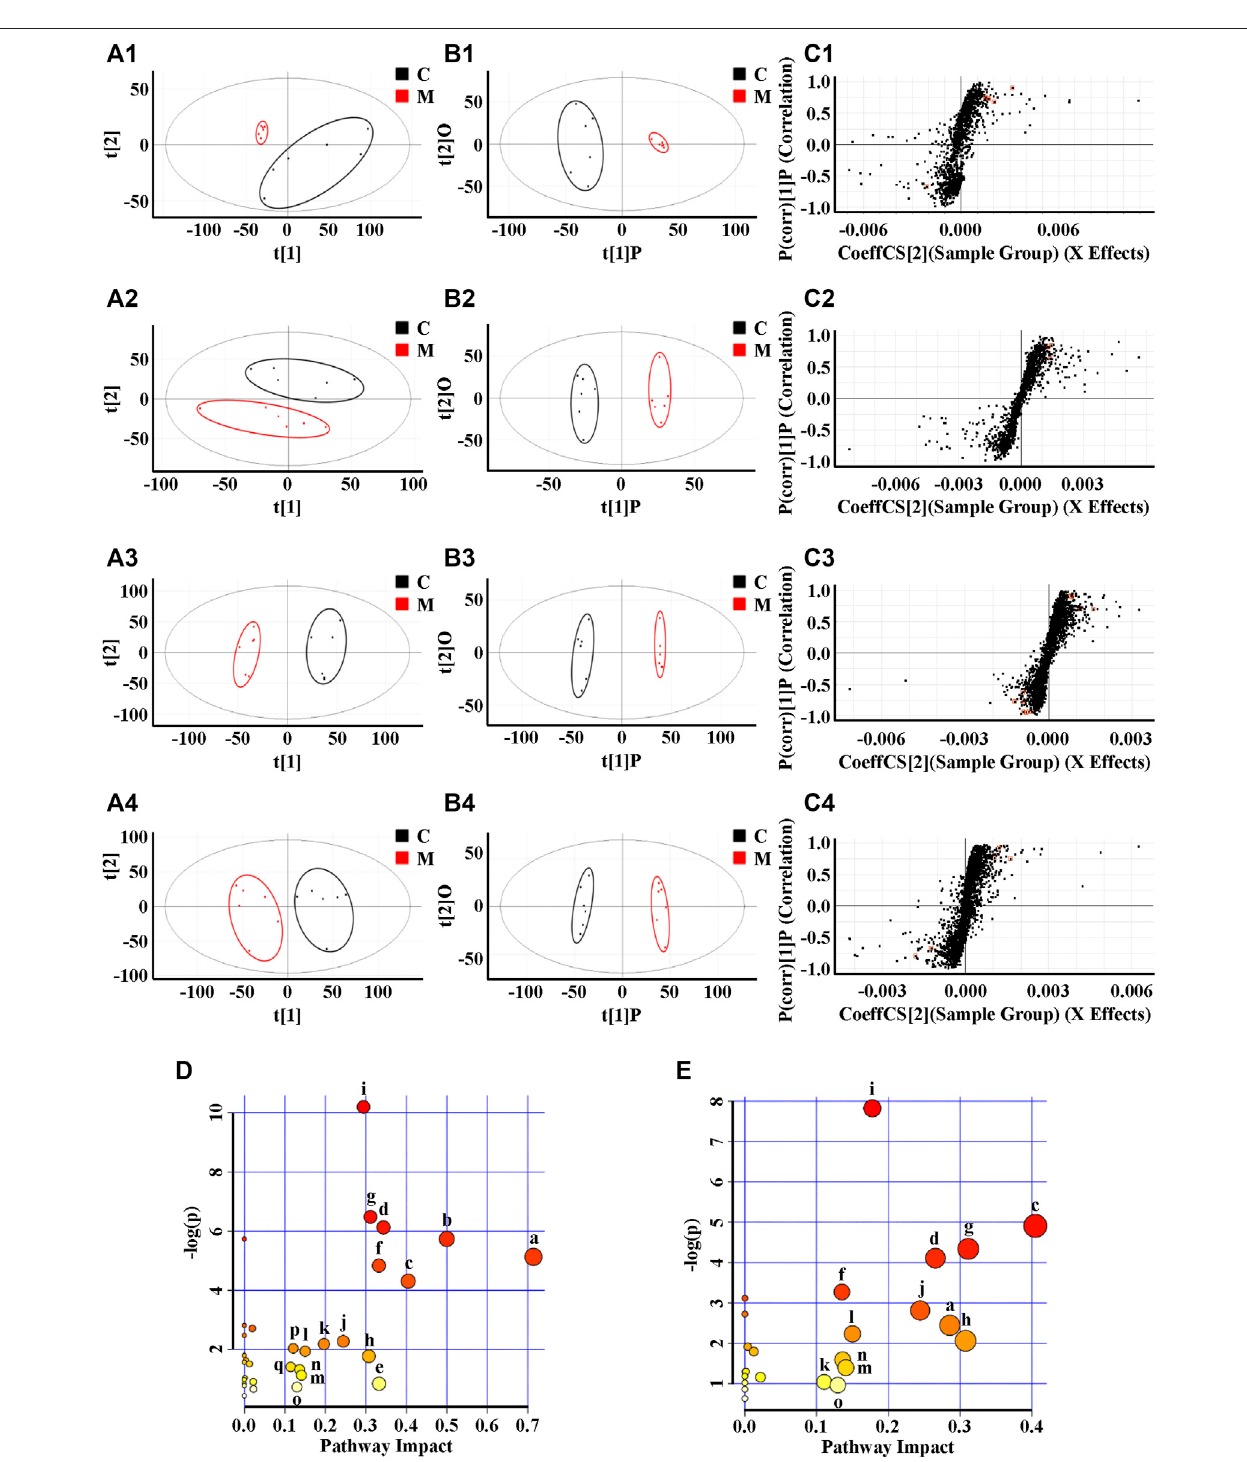
FIGURE 3 | PCA (A) , OPLS-DA (B) and S-plot of OPLS-DA (C) for plasma (1, 2) and urine (3, 4) of model group (red) vs. control group (black) in positive (1, 3) and negative(2,4)ionmode;metabolicpathwaysinvolvedinallmarkersinplasmaandurineforinsomnia (D) ;metabolicpathwaysinvolvedinpotentialmarkersinplasmaand urine regulated by ZSS (E) . (a) Taurine and hypotaurine metabolism; (b) D-glutamine and D-glutamate metabolism; (c) phenylalanine metabolism; (d) pentose and glucuronateinterconversions;(e)arachidonicacidmetabolism;(f)alanine,aspartateandglutamatemetabolism; (g)histidinemetabolism;(h)caffeinemetabolism;(i) arginine biosynthesis; (j) glycerophospholipid metabolism; (k) arginine and proline metabolism; (l) biotin metabolism; (m) lysine degradation; (n) selenocompound metabolism; (o) tyrosine metabolism; (p) one carbon pool by folate; (q) terpenoid backbone biosynthesis.